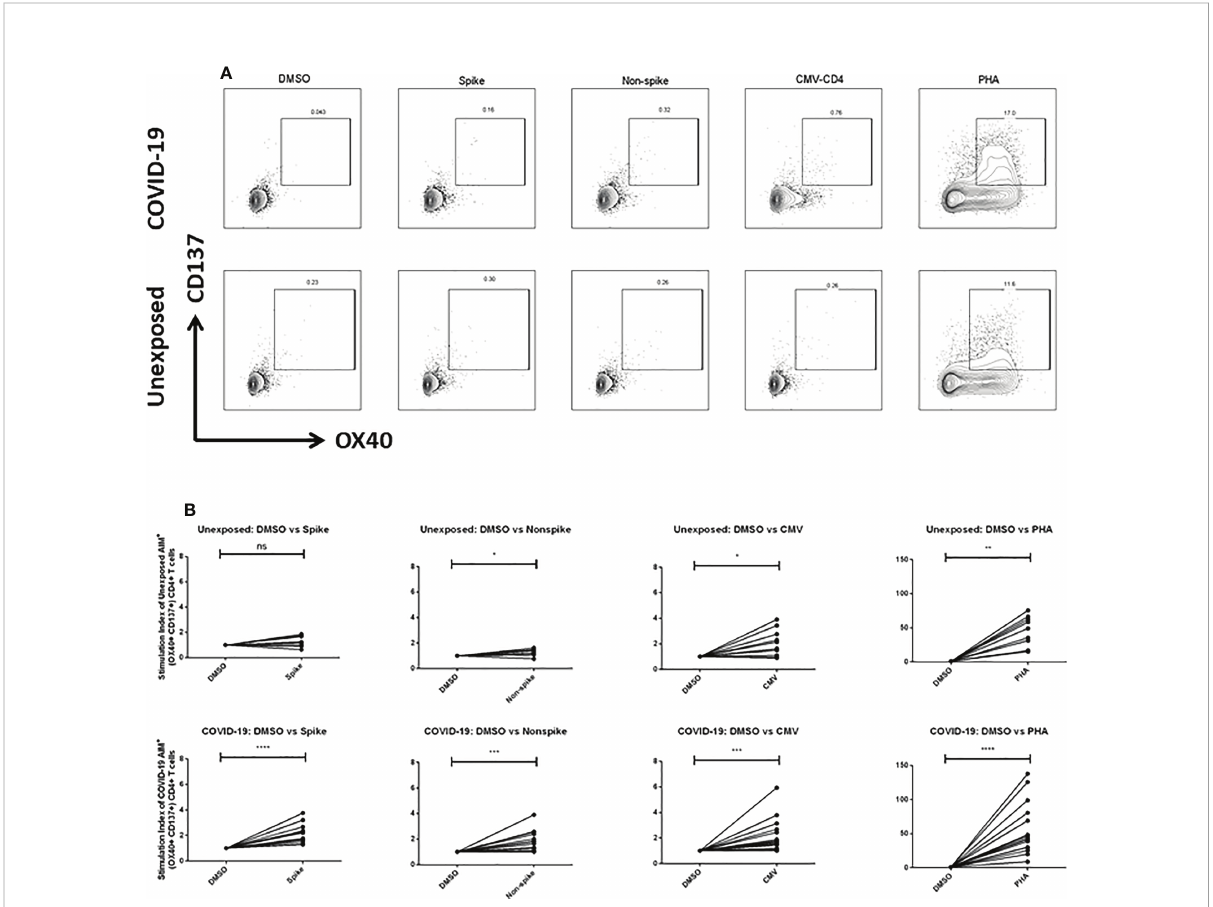
FIGURE 3 (A) Representative plot for Fluorescence-activated cell sorting (FACS) gating for AIM+ (OX40+ CD137+) cells gated on CD4+ T cell; (B) AIM+ CD4+ T cell reactivity in unexposed control (n=10) and COVID-19 cases (n=15) between the negative control (DMSO) and different antigen- speci fi c stimulations (Spike, Non-spike MP, CMV, PHA). Wilcoxon matched pairs signed rank test was performed to compare between groups. *p <0.05; **p <0.01; ***p < 0.001; ****p < 0.0001; ns: non-signi fi